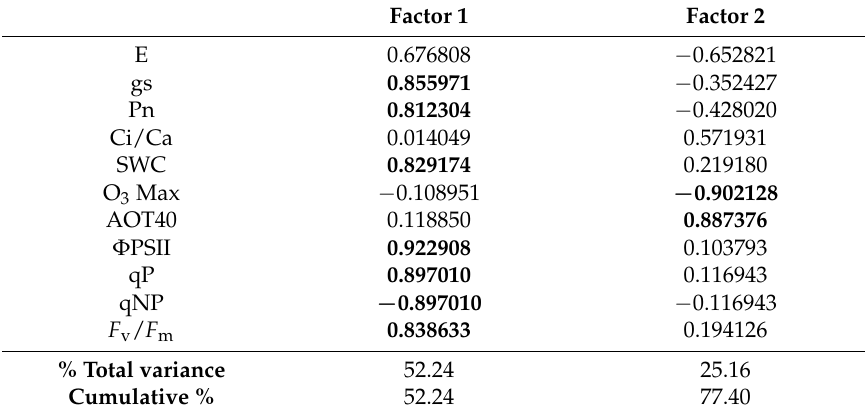
Table 3. Principal component analysis of the considered ecophysiological and environmental parameters, obtained from pooling together the data from DOT 28 to R27 after the beginning of both the water stress and EDU treatments. Component loadings > 0.7, which represent the correlation of the original variables with each of the new factors, are highlighted in bold. See text for further